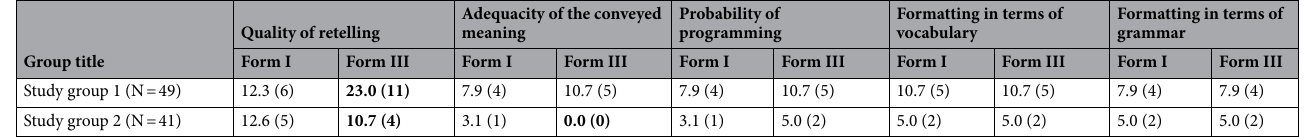
Table 2. Retelling parameters, scores, mean for Russian and Kazakh populations, % + (the number of children). Significant values are in